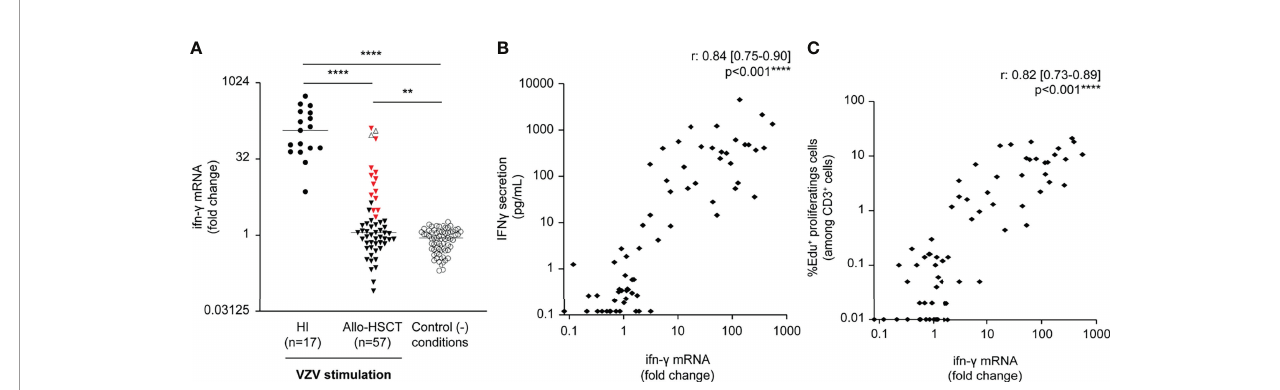
FIGURE 2 | Ex vivo whole blood VZV-stimulation and correlations between VZV-speci fi c immune functional assays. Whole blood (100 µl) from healthy individuals (HI, n = 17) and allogeneic hematopoietic stem cell transplant recipients (allo-HSCT, n = 57) was stimulated 24 h by VZV antigen (inactivated supernatants from VZV- infected MRC-5 cells, 20 µg/ml) or supernatants from VZV-uninfected MRC-5 cells (control condition). (A) The relative quanti fi cation of ifn- g gene expression levels is presented as fold change. Red triangles represent recipients de fi ned as VZV responders, according to IFN- g release in supernatants from VZV-stimulated peripheral blood mononuclear cells (see Figure 1 ). Clear triangles represent recipients who developed herpes zoster-related manifestations. Bars represent median and P - values were obtained using the Kruskal – Wallis test; ** P <.01, **** P <.0001. (B) Correlation between ifn- g mRNA gene expression (fold change) and IFN- g release in supernatants from VZV-stimulated PBMC quanti fi ed using the ELLA nano fl uidic system, using Spearman rank-correlation test. (C) Correlation between ifn- g mRNA gene expression (fold change) and percentage of EdU + cells (among CD3 + ) measured by fl ow cytometry, using Spearman rank-correlation test. Data were missing for three VZV-stimulated